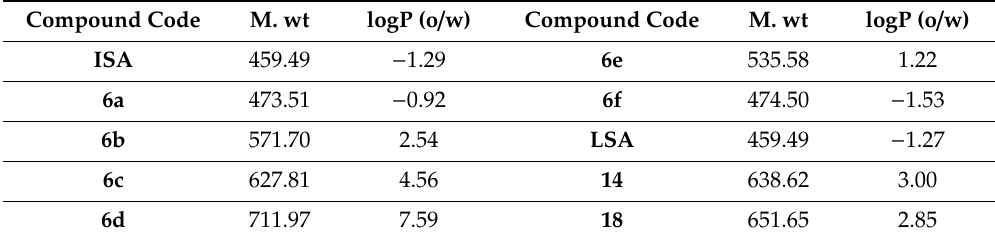
Table 3. Predicted logP values of the respected